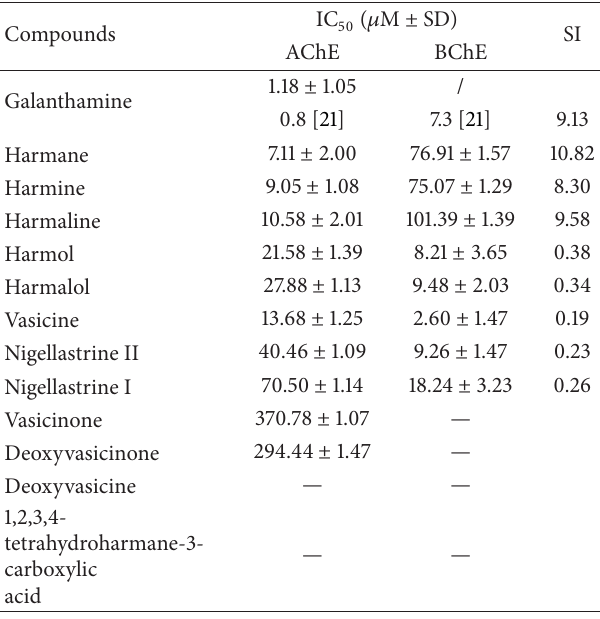
Table 1: Inhibitory activity (IC compounds investigated against AChE and